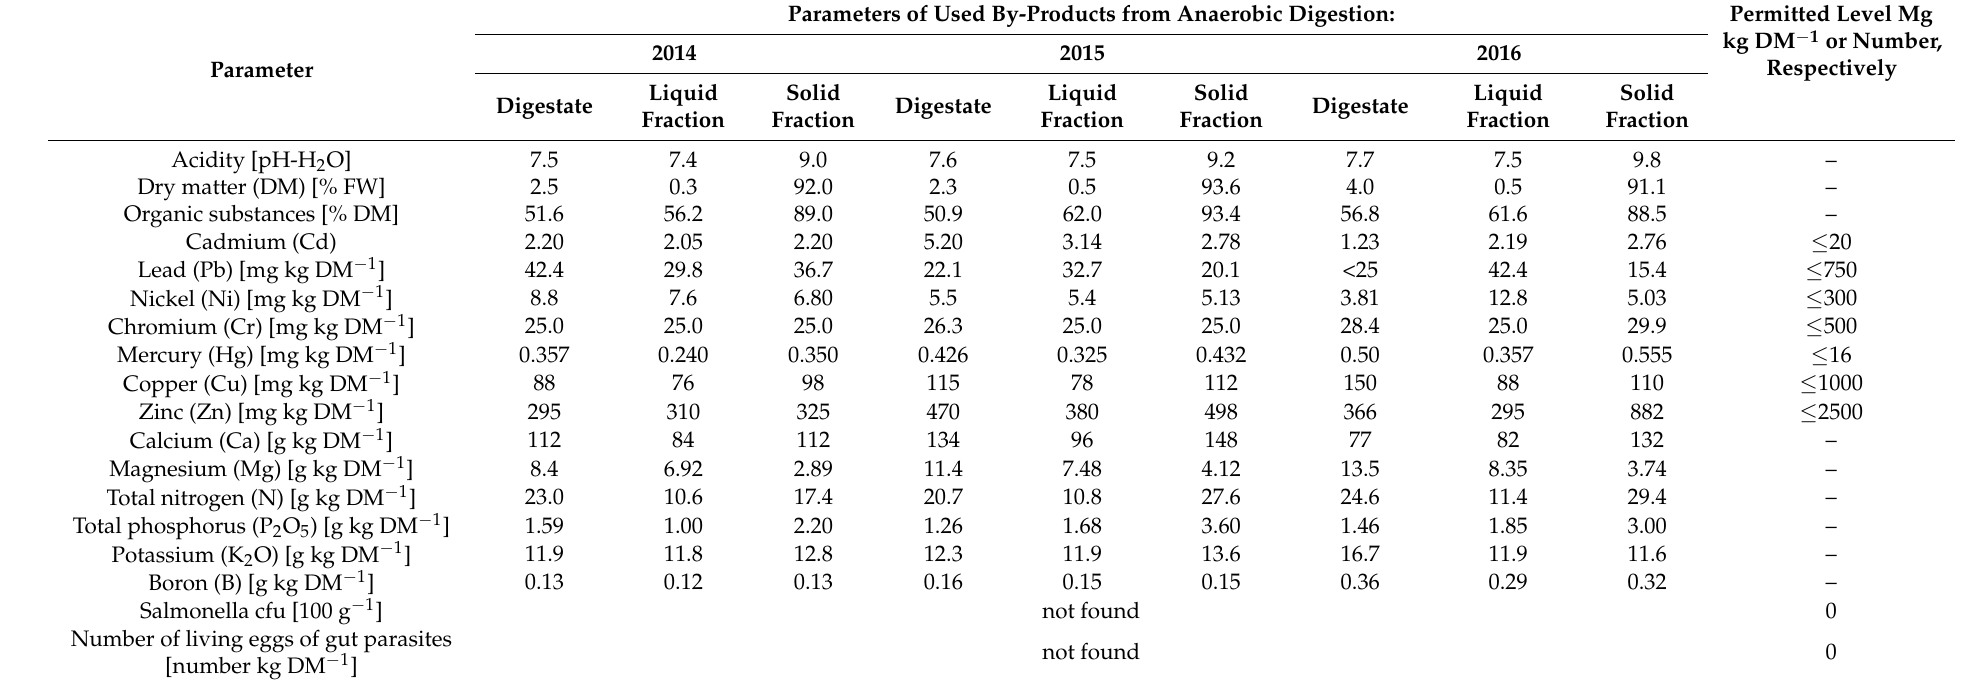
Table 2. Comparison of the quality of the experimental digestate against the permissible thresholds. Parameters of Used By-Products from Anaerobic Parameter